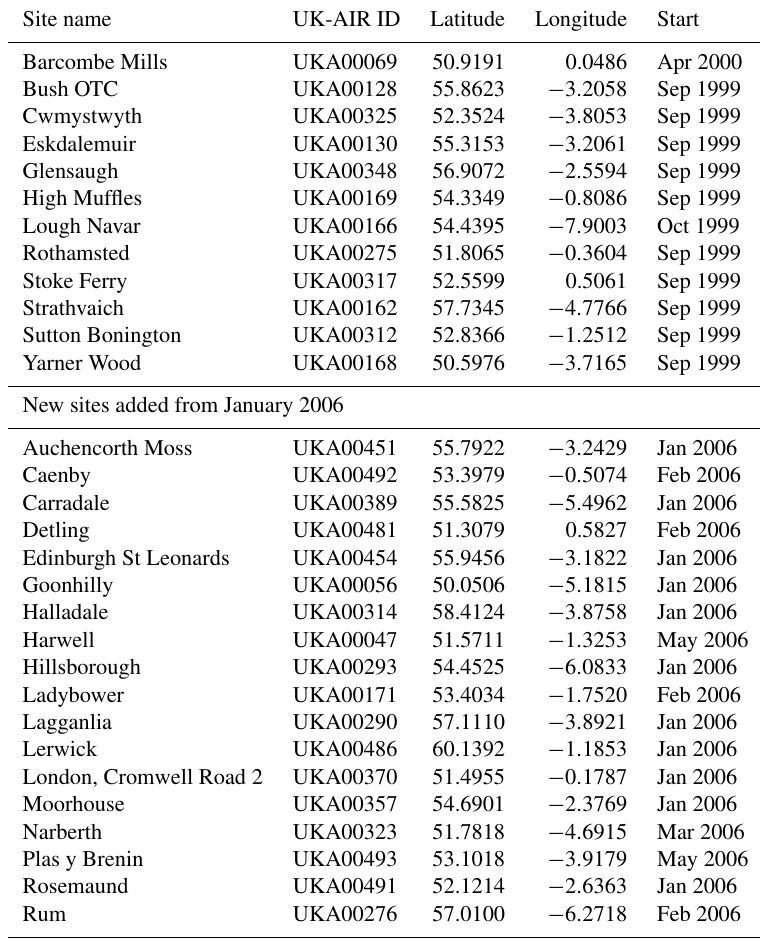
Table 1. List of sites in the UK Acid Gas and Aerosol Network (AGANet) with details of locations, start dates, and UK-AIR ID (https: //uk-air.defra.gov.uk/networks/network-info?view=aganet, last access: 23 October